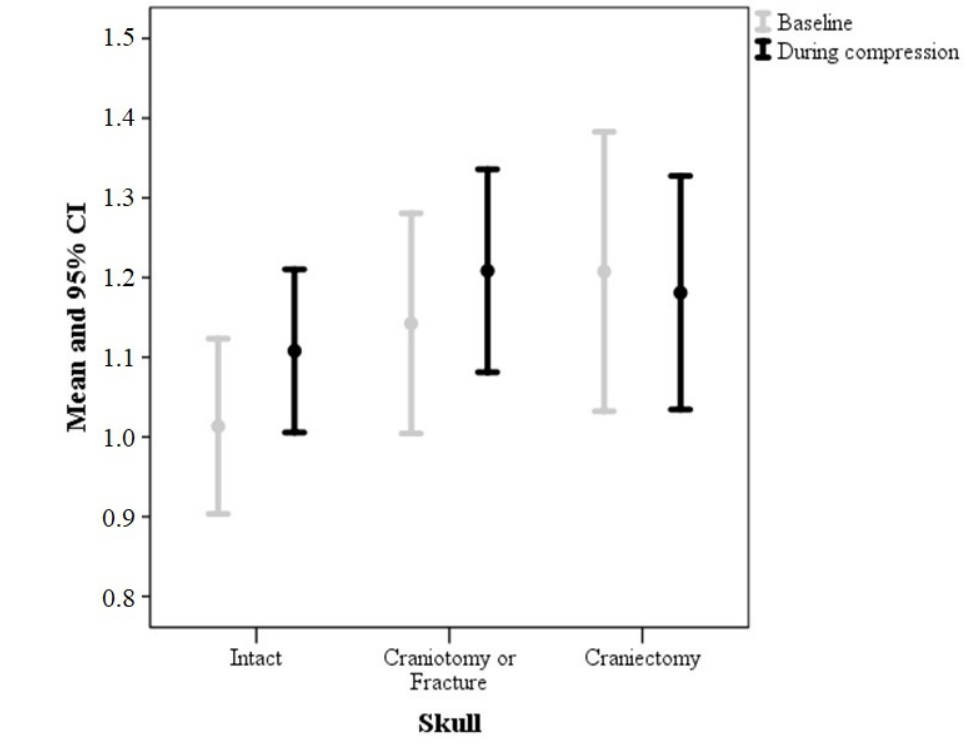
Figure 5. P2/P1 ratio according to skull defect.